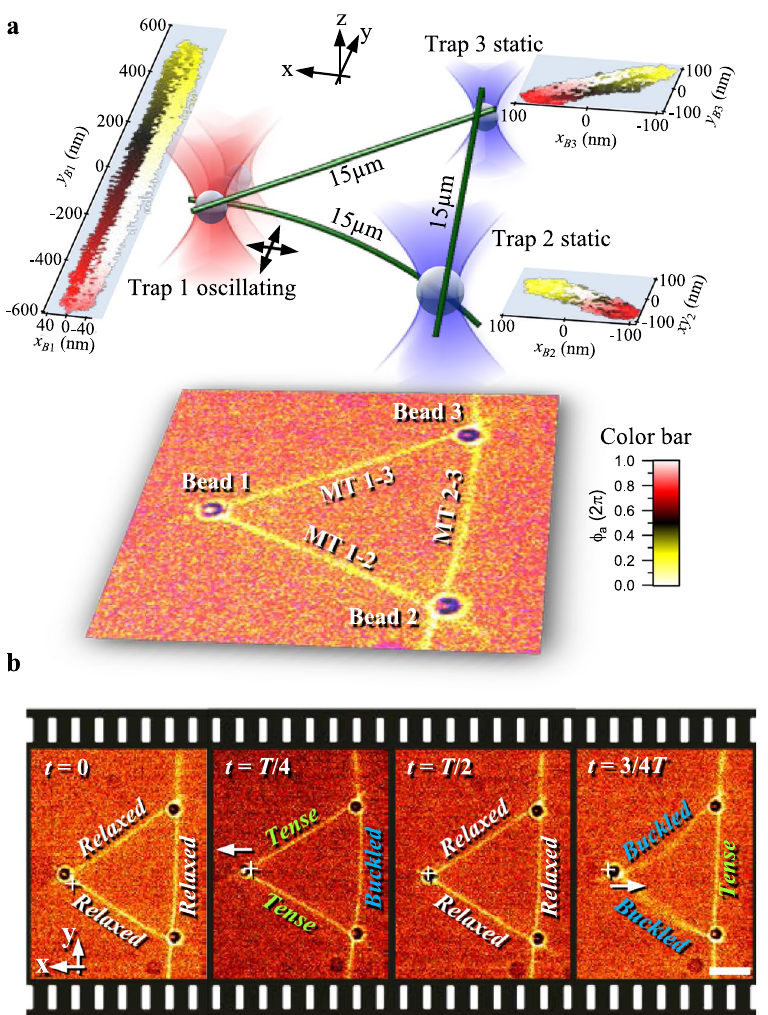
Figure 5. Probing an equilateral triangular network of GMPCPP filaments. ( a ) Design of experiment in pseudo 3D with overlay of fluorescence and brightfield image (bottom). Scatterplots of absolute bead positions during a tangential oscillation in y direction are shown color coded over the current phase φ a of the actor trap. ( b ) Overlay of fluorescence and brightfield images of the characteristic time points during one radial (x) oscillation period at f a = 0.1 Hz. Scale bar: 5 µ